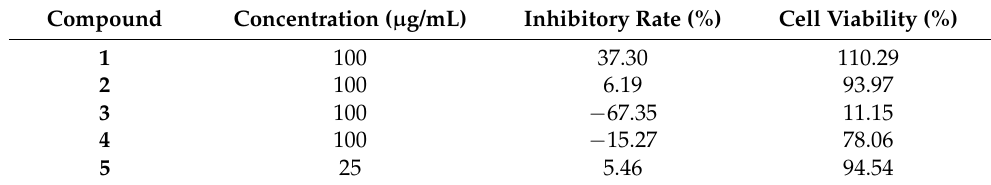
Table 2. Inhibition of lipid accumulation in HepG2 and cytotoxicity of compounds 1 – 5